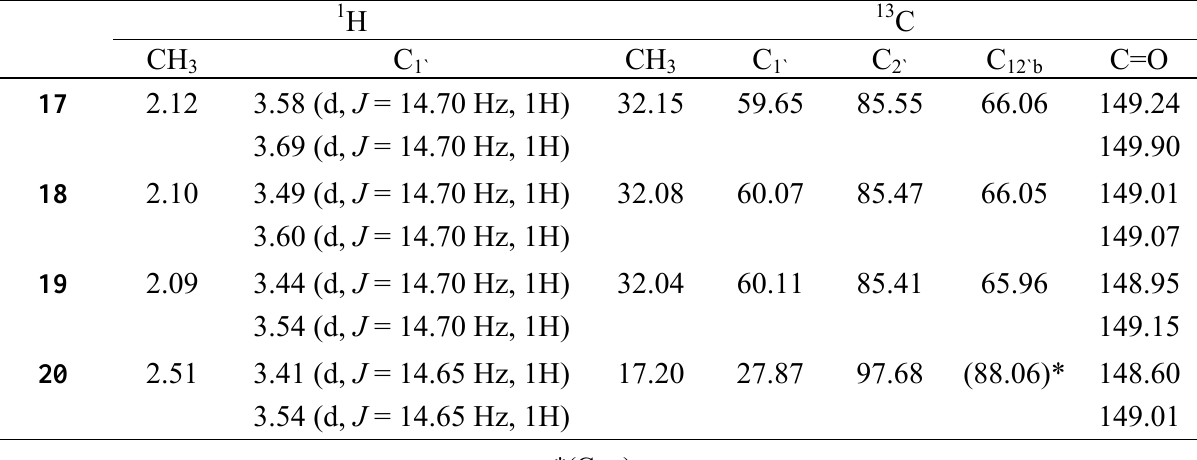
Table 5 . Partial 1 H and 13 C-NMR data for the spiro compounds 17- 20